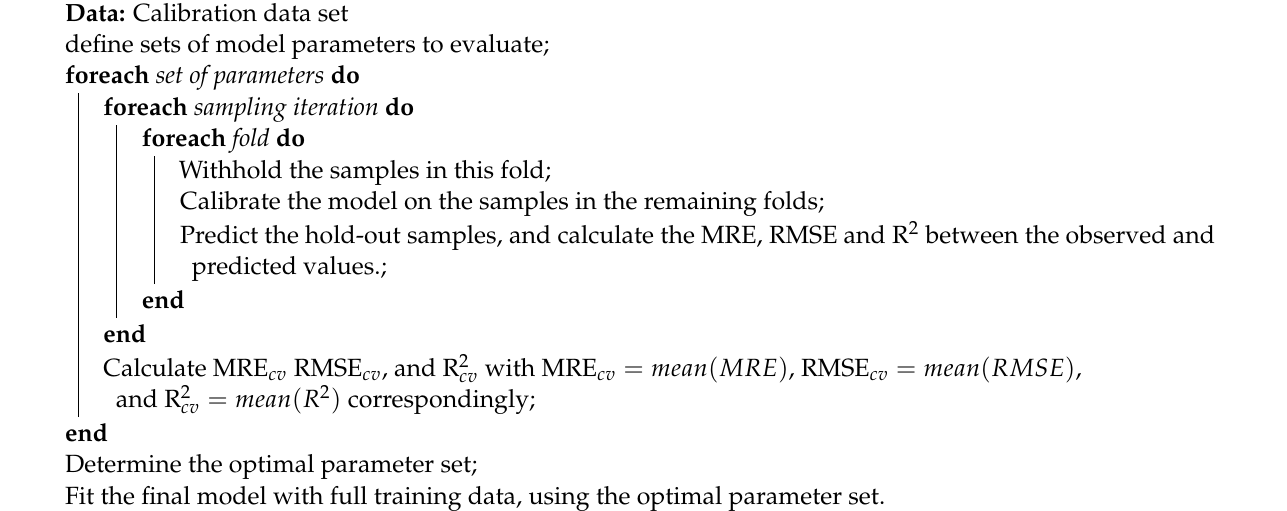
Algorithm 1: Hyperparameter optimization and model calibration algorithm. Data: Calibration data